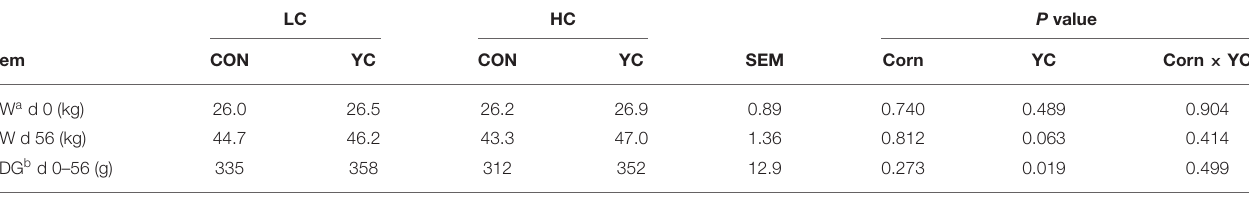
TABLE 2 | Growth performance of fattening lambs fed experimental diets containing a low (LC) or high (HC) proportion of corn and supplemented with nil (CON) or yeast culture (YC) ( n = 14 per treatment). LC HC P value